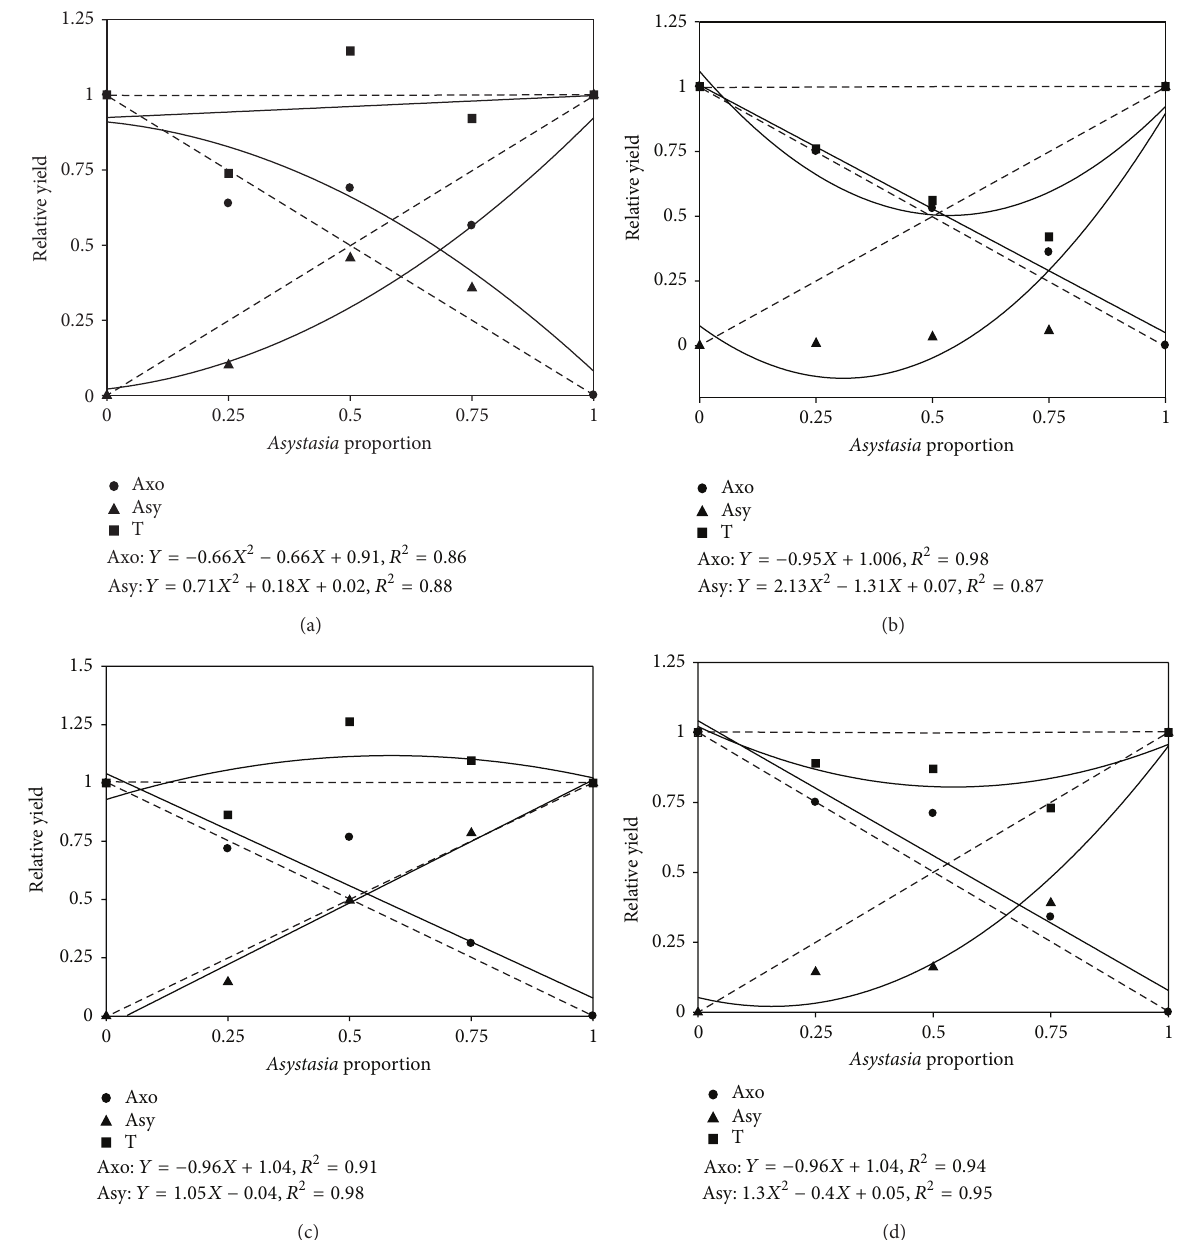
Figure 2: Interaction between Asystasi gangetica (Asy) and Axonopus compressus (Axo) in full sunlight with low density (a), A. compressus in fullsunlightwithhighdensity(b), A.compressus inshadewithlowdensity(c),and A.compressus inshadewithhighdensity(d)inreplacement series experiments at 10wk after planting. T =